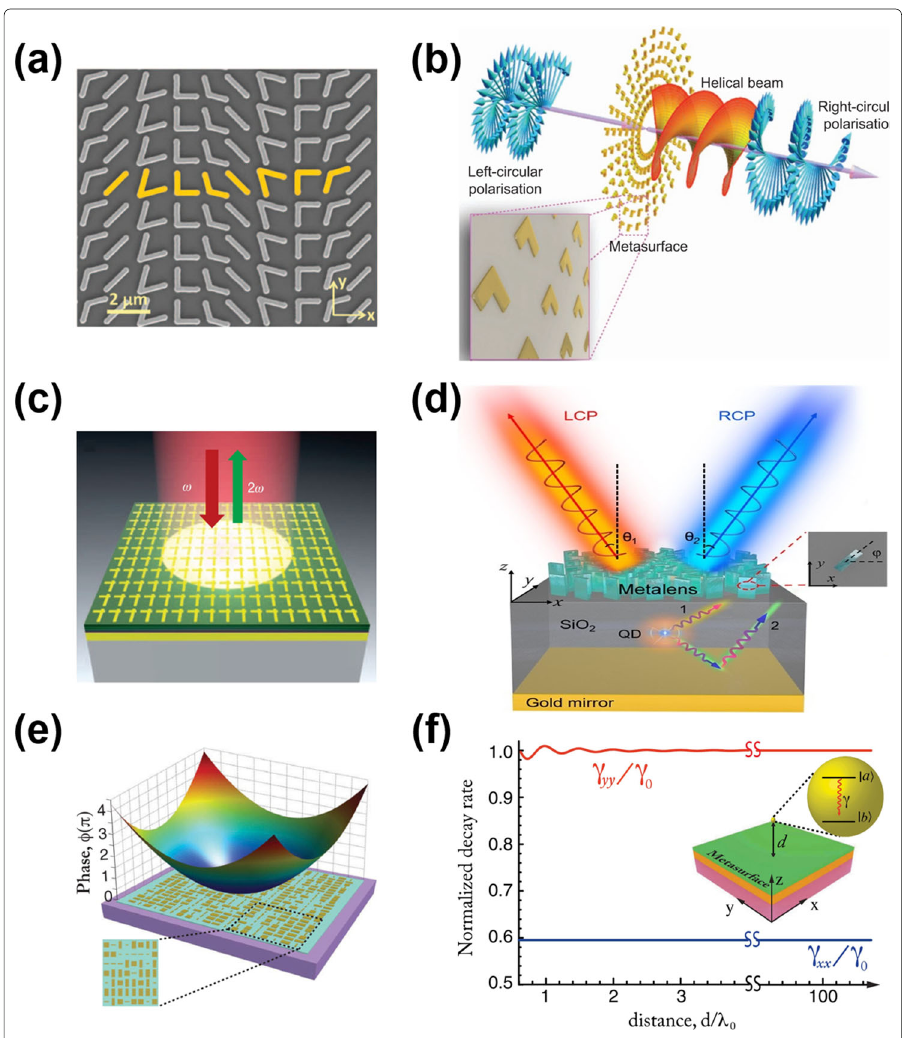
Fig. 9 The basic concepts and Purcell enhancement of metasurface. a The SEM image of typical metasurface [301]. The schematic diagrams of controlling the ( b ) phases [302], ( c ) frequencies [303], and ( d ) polarizations [304] of electric field by metasurface. e Metasurface controlling the light polarization for anisotropic quantum vacuum [305]. f Anisotropic Purcell factors of x - and y -polarized emitters in the metasurface ( e ) [305]